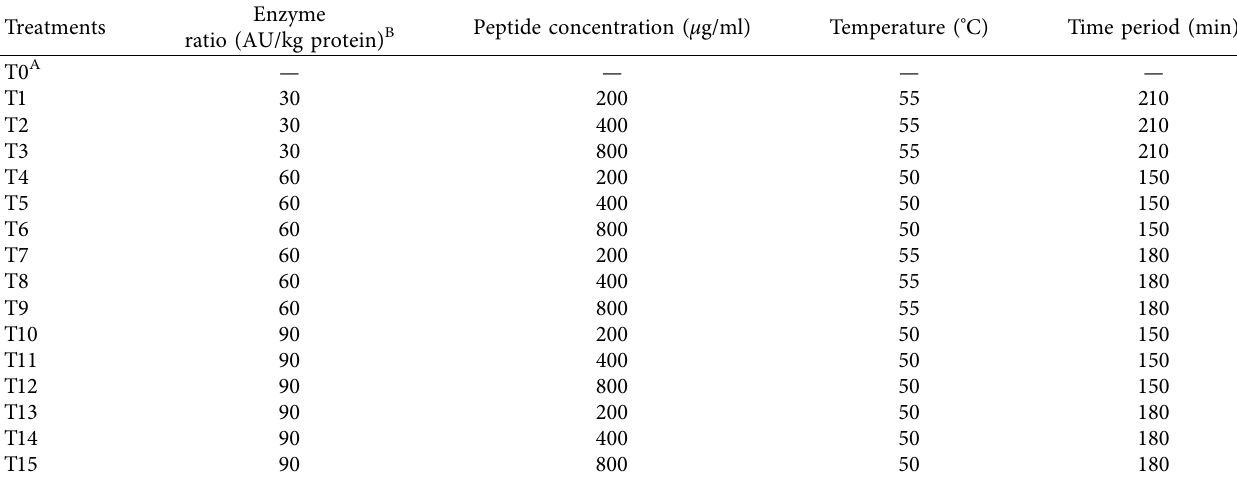
Table 1: Hydrolysis condition of quinoa